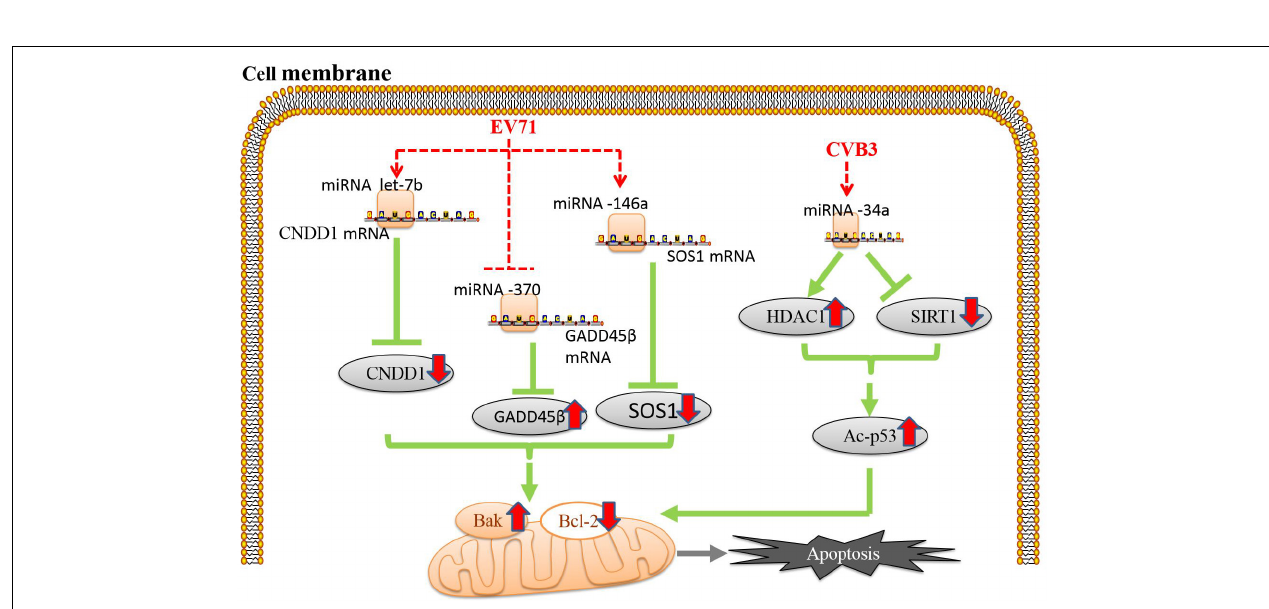
FIGURE 2 | Enteroviruses regulate apoptosis through the PI3K/AKT pathway. (a) Enteroviruses interact with cellular receptors to induce JNK phosphorylation. (b) Activated JNK activates Bax-dependent apoptosis. (1) Enteroviruses interact with cell receptors to activate the PI3K/AKT pathway. (2) PI3K activates Akt by phosphorylating threonine (Thr) 308 and serine (Ser) 473 on Akt. (3) Activated Akt phosphorylates NF- κ B, MDM2, and ASK1. Phosphorylation of NF- κ B activates its transcription function, allowing it to enhance the expression of the antiapoptotic protein Bcl-xl. Phosphorylated MDM2 can inactivate or degrade P53, thereby blocking the P53-mediated proapoptotic transcription reaction. (4) Activated Akt directly phosphorylates Bad, Bax, and caspase 9, causing them to lose their ability to promote apoptosis and thereby effectively blocking apoptosis. (5) ASK1 is the upstream regulatory factor of JNK, and phosphorylated ASK1 negatively regulates the activation of JNK, thereby delaying activation of the proapoptotic protein Bax and effectively inhibiting apoptosis.